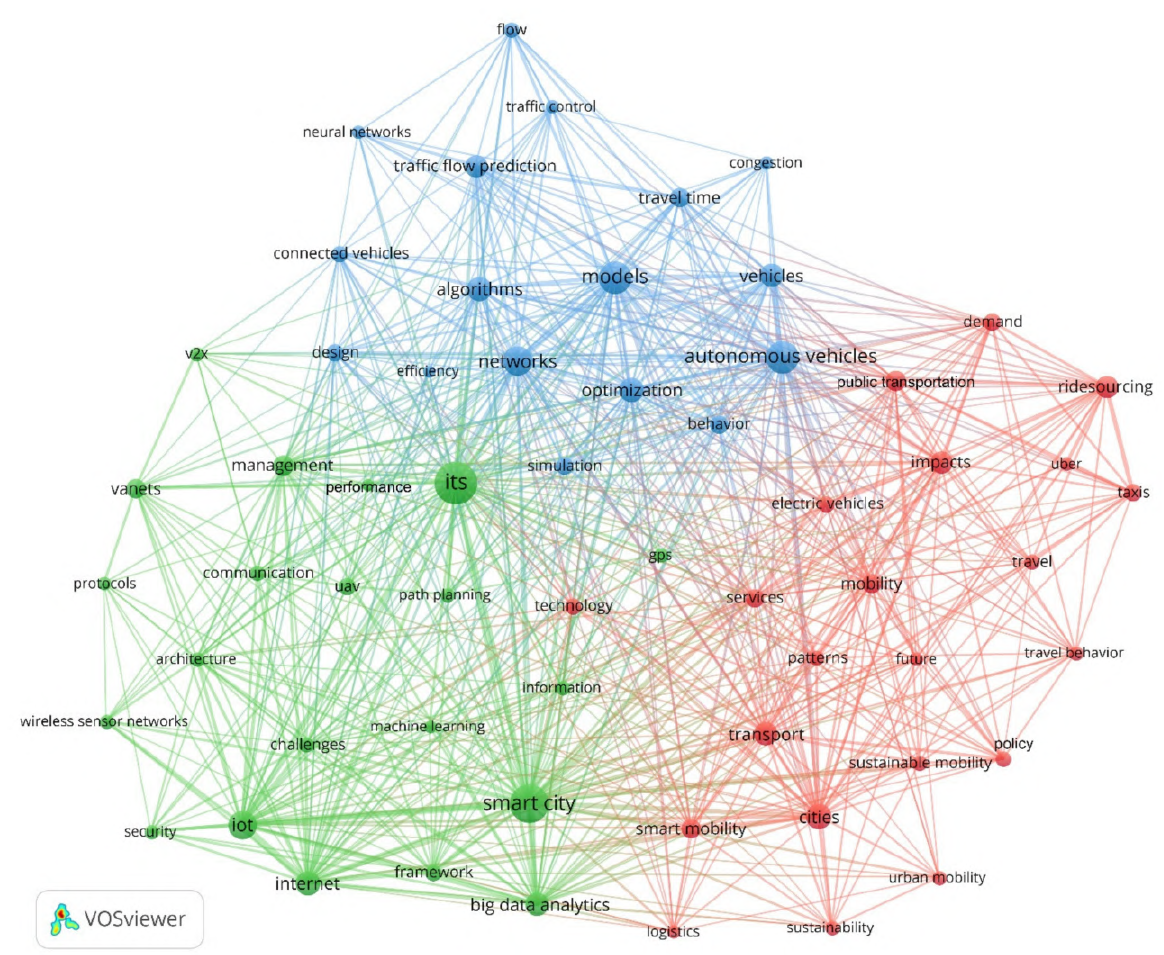
Figure 10. Mapping Keywords Output from 2016 to 2019. Illustration by